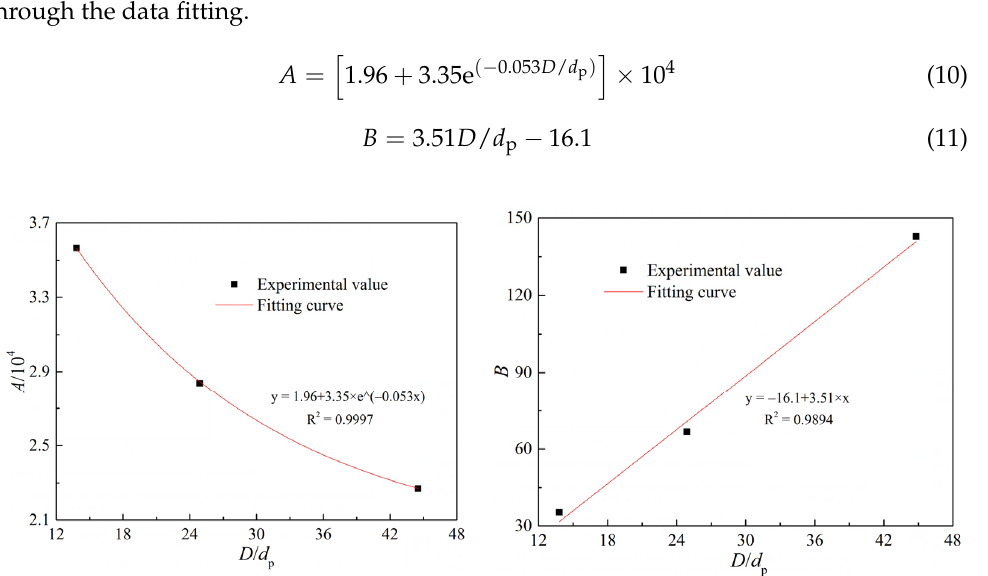
Figure 6. Quantitative relationships of coefficients A and B with D / d p.